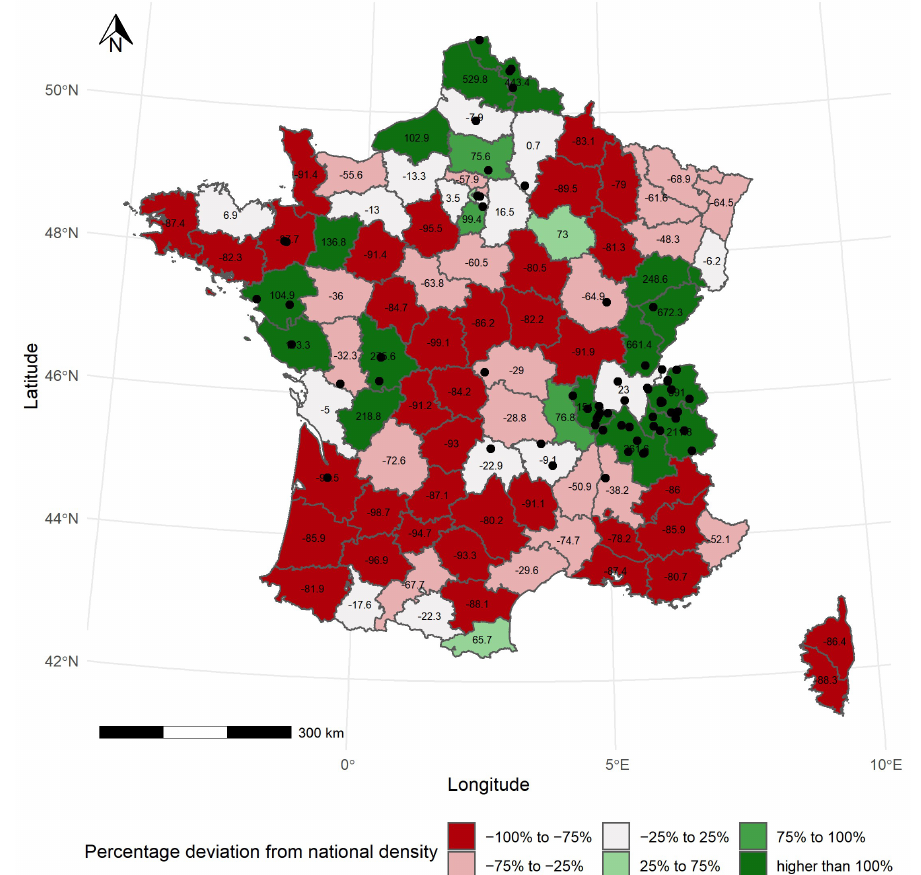
Figure 2. Distribution of fungal records across administrative units in France. The gradual color vari- ation represents the difference between the density of recorded observations of each administrative unit and the density at the national level, expressed in percent. The highly localized adminis- trative units of Ile-de-France are not represented. For these departments, values are respectively 318.54 (Paris), 51.71 (Hauts-de-Seine), − 49.69 (Seine-Saint-Denis) and − 20.61